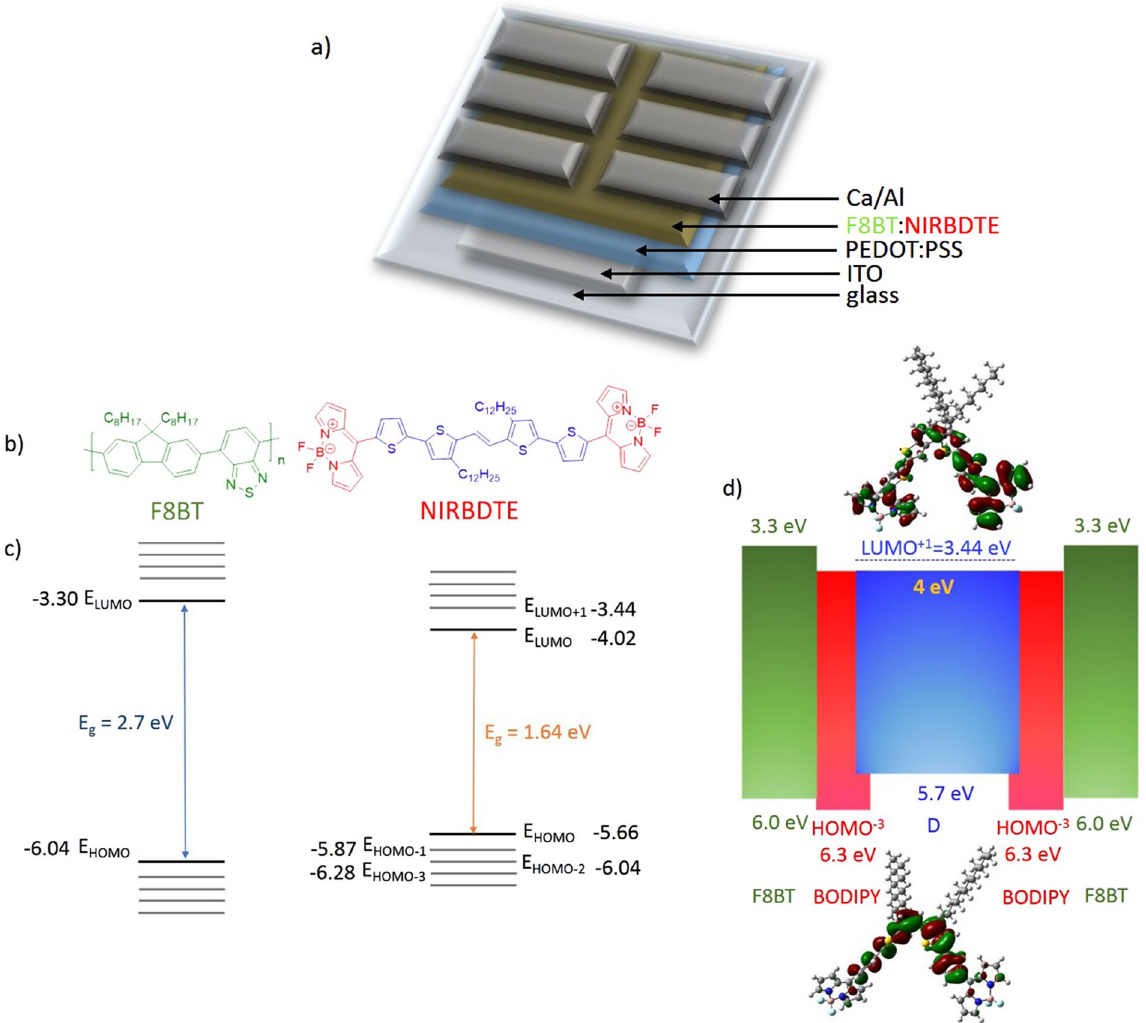
Figure 1. ( a ) Device structure, including details of the different layers, ( b ) chemical structure of F8BT and NIRBDTE, ( c ) the energy levels of F8BT and NIRBDTE and ( d ) the related band diagram (both extracted from the cyclic voltammetry data) of the emitting blend F8BT:NIRBDTE as active layer (in their isolated conditions, before heterostructure formation) with the density-functional theory (DFT) HOMO and LUMO wavefunction plots of NIRBDTE (calculated with the B3LYP/6-31 G(d,p) basis set). The effective HOMO and LUMO of NIRBDTE are those of the part indicated in blue, but we also illustrate in red the local electronic structure of the BODIPY moieties to emphasise the insight gained from DFT calculations of the frontier levels charge distribution, and the “hole-funnelling” effects towards the central